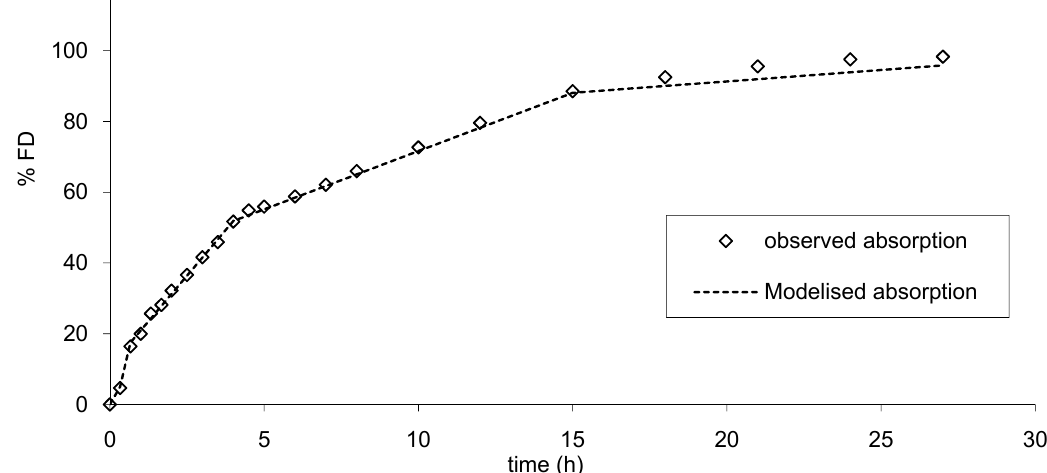
Figure 9. Modelization of a multi zero order absorption according to Equation